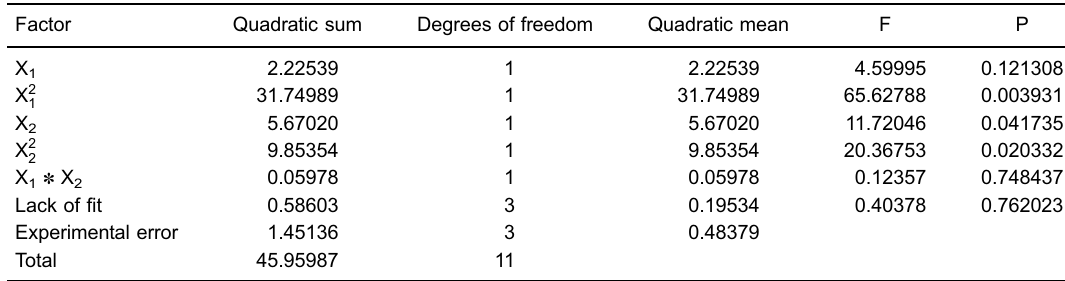
Table 3. ANOVA for the surface tension of the biosurfactant produced by Streptomyces sp. DPUA1559 in mineral medium containing 1% residual soybean oil after 96 h of